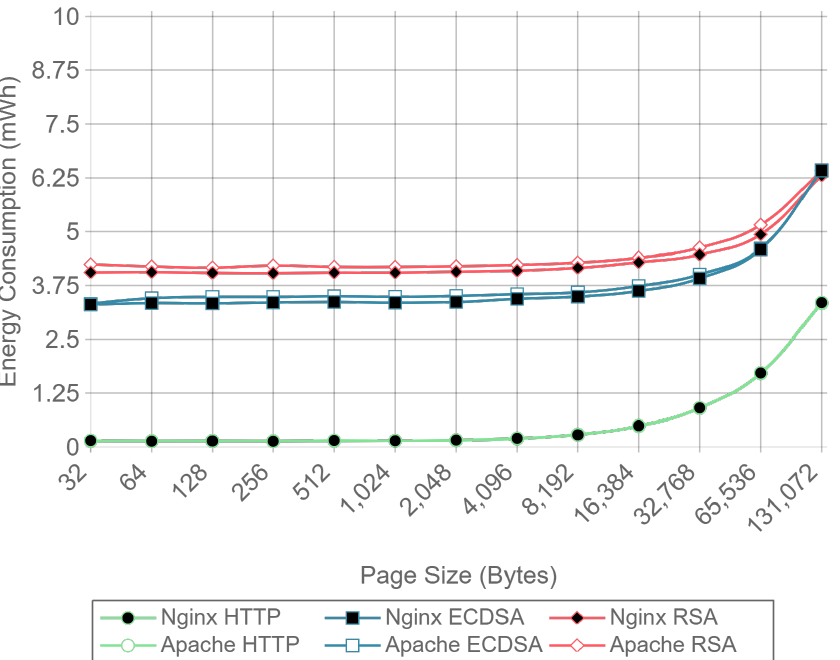
Figure 17. Client-side page size versus energy consumption for Apache2 and Nginx with 16 concurrent clients.